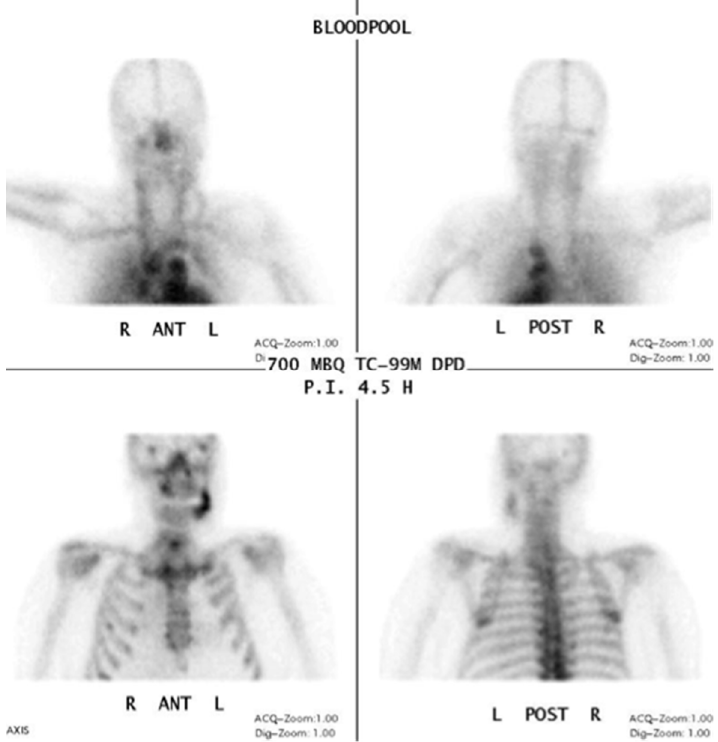
Figure 8. Planar scintigraphy (Siemens, Symbia) Blood pool phase. Patient: 66 years old, male, secondary osteoporosis due to castration, alendronate. AAMOS staging: stage 3.